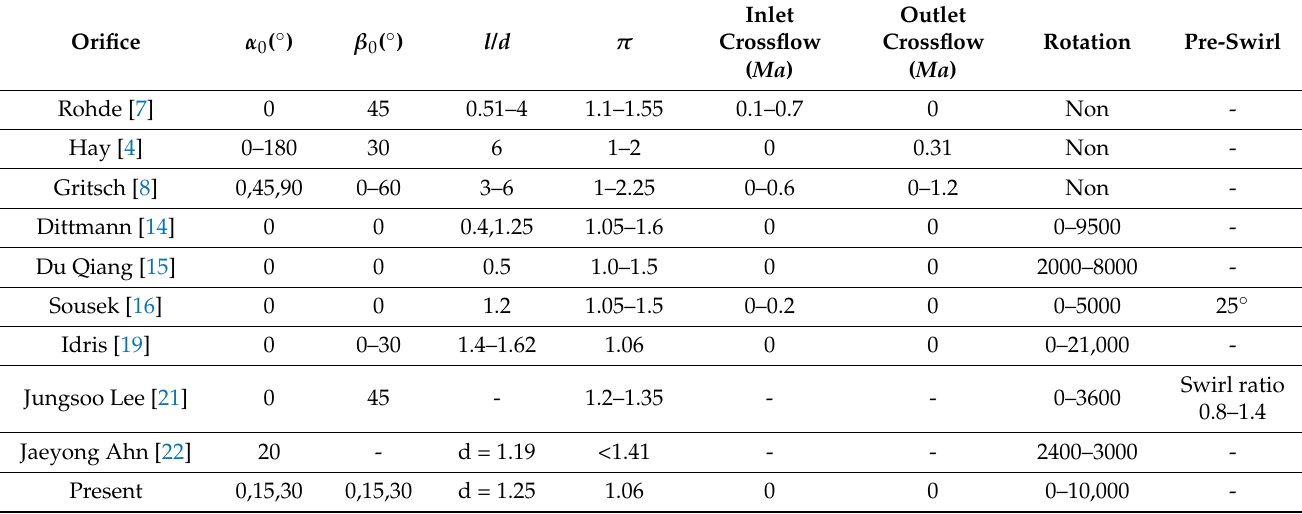
Table 1. Literature review of relevant